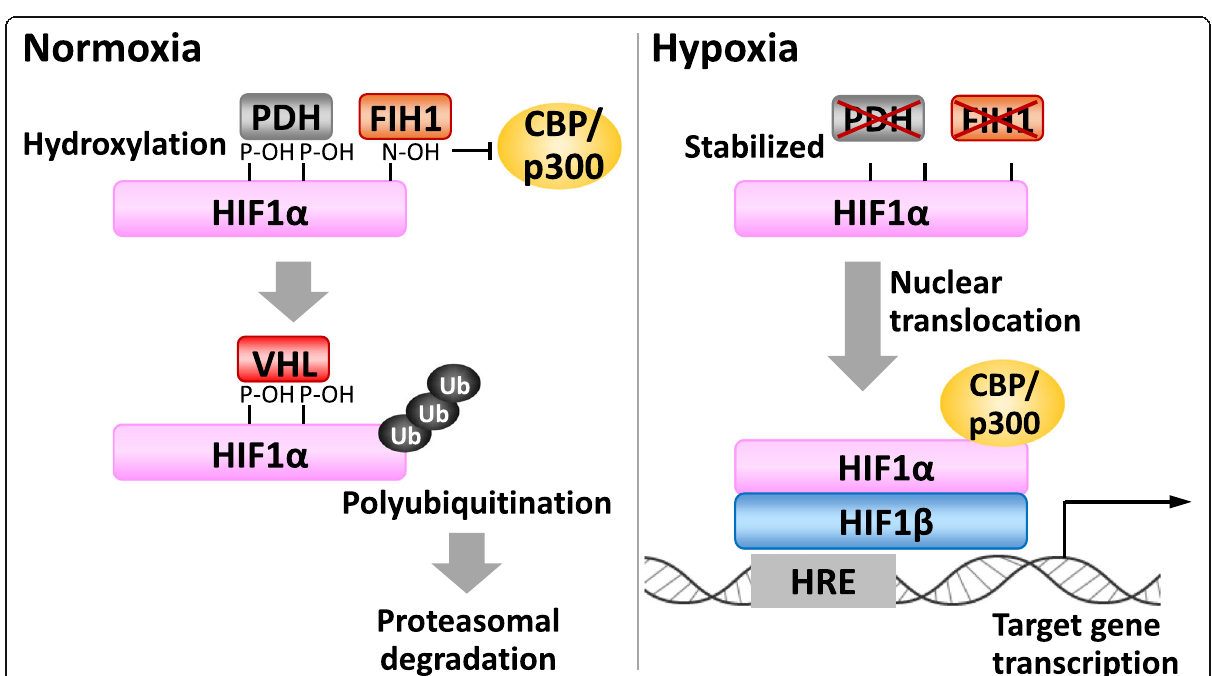
Fig 3 HIF1 α turnover and its transcription function. FIH1, factor inhibiting HIF1; HIF, hypoxia-inducible factor; HRE, HIF-responsive element; PHD, prolyl hydroxylase; VHL, von Hippel-Lindau